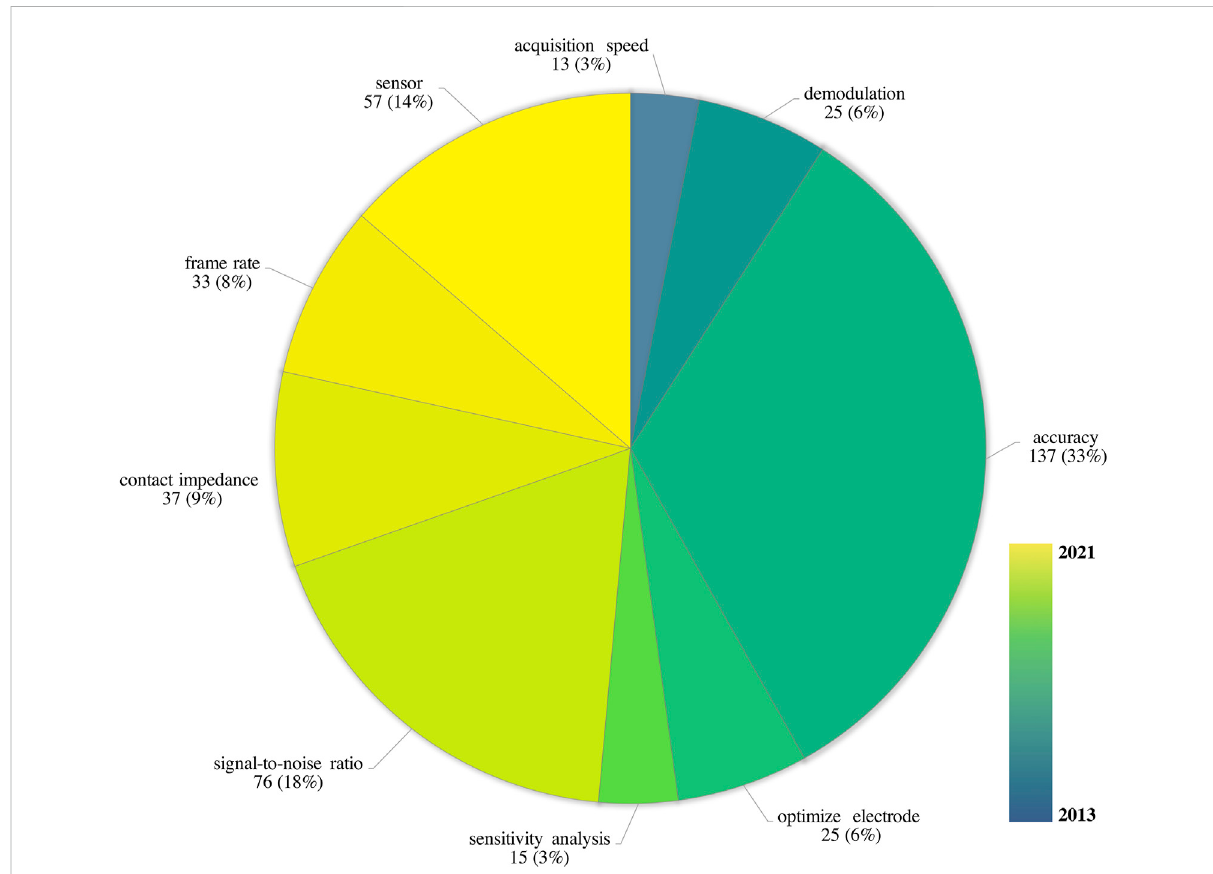
FIGURE 9 Development of evaluating indicators for EIT hardware performance. The palate color of the pie chart represented each indicator, the palate aerarepresentedthenumber(percentage%)ofeachindicator,thegradientcolorbarfrombluetoyellowindicatedtheaverageyearofoccurrenceM (IQR) for each indicator calculated from the publishing year of the source